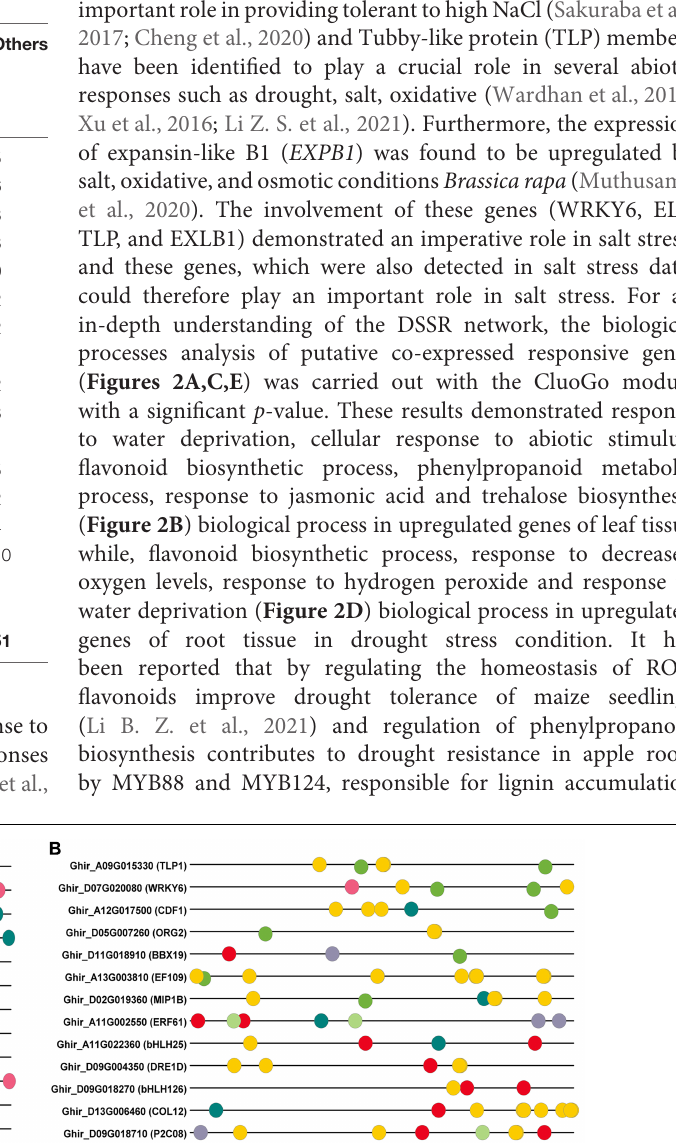
Frontiers in Plant Science |